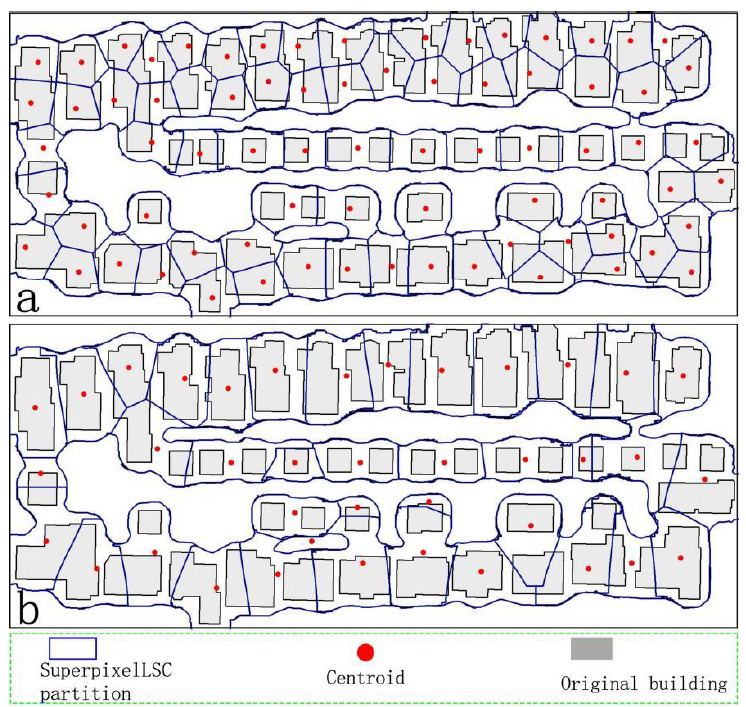
Figure 6. LSC superpixel segmentation is used to segment the typification areas of the building. ( a ) Small Aperture superpixel Blocking Results. ( b ) Big Aperture superpixel Blocking Results.